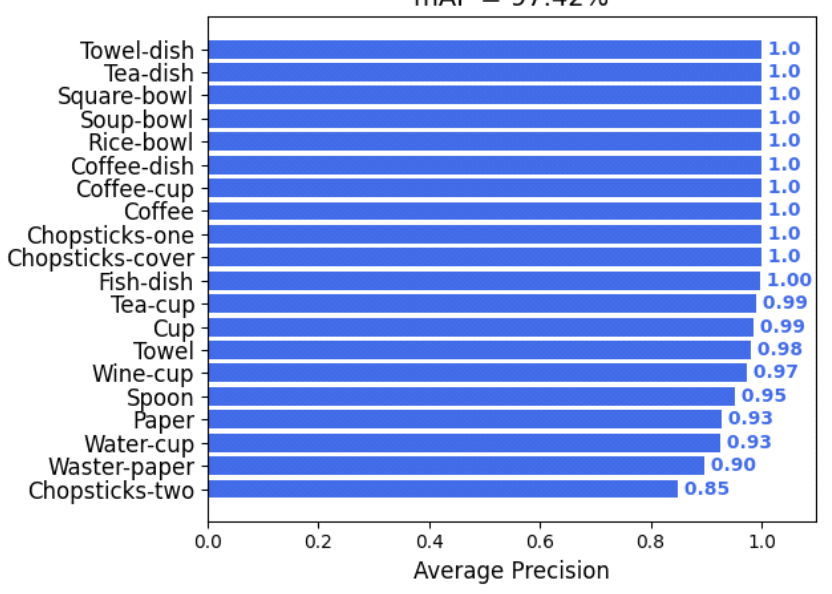
Figure 8. AP and mAP of YOLO-GD on Jetson Nano with quantification by